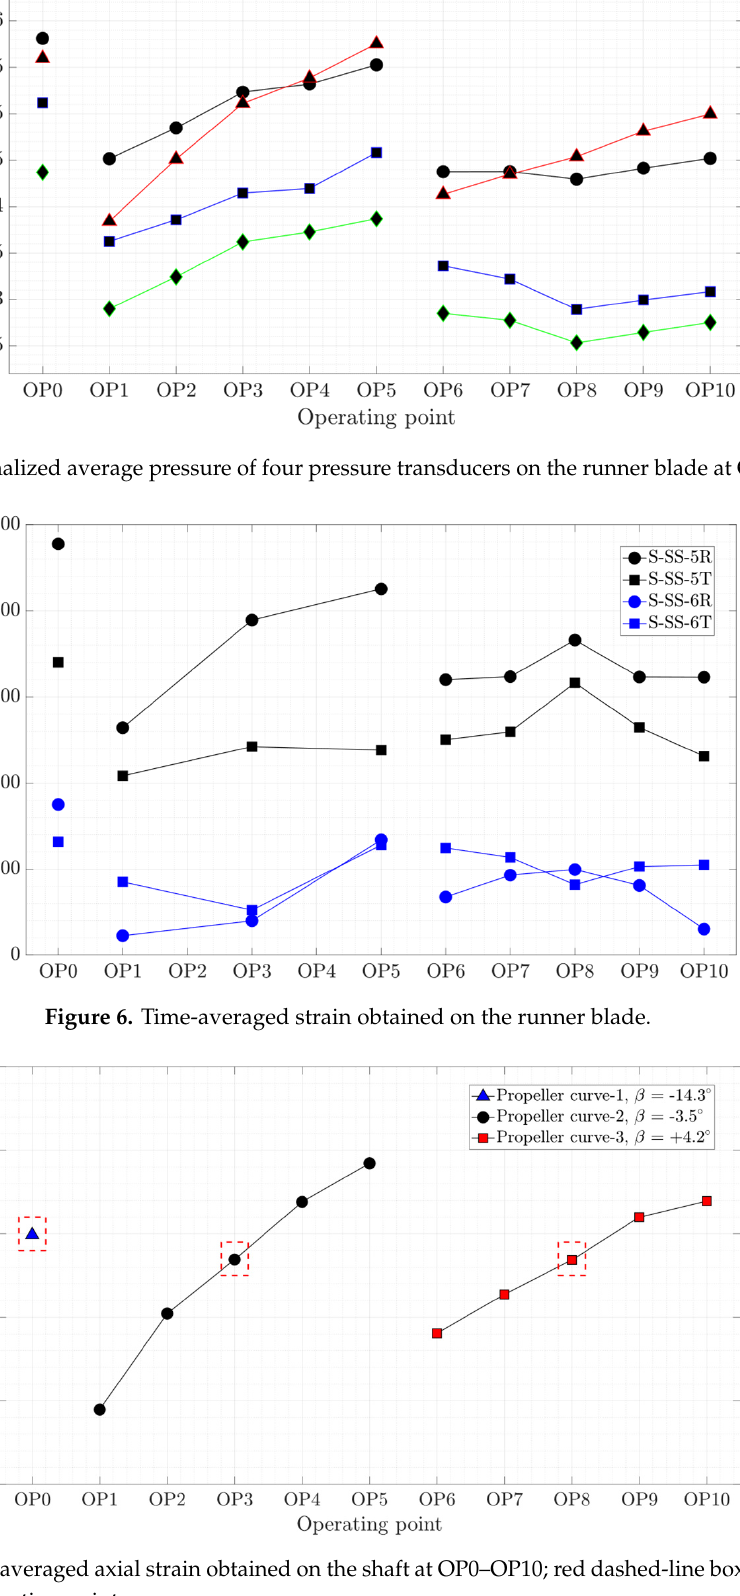
Figure 7. Time-averaged axial strain obtained on the shaft at OP0–OP10; red dashed-line boxes indicate the on-cam operating points.